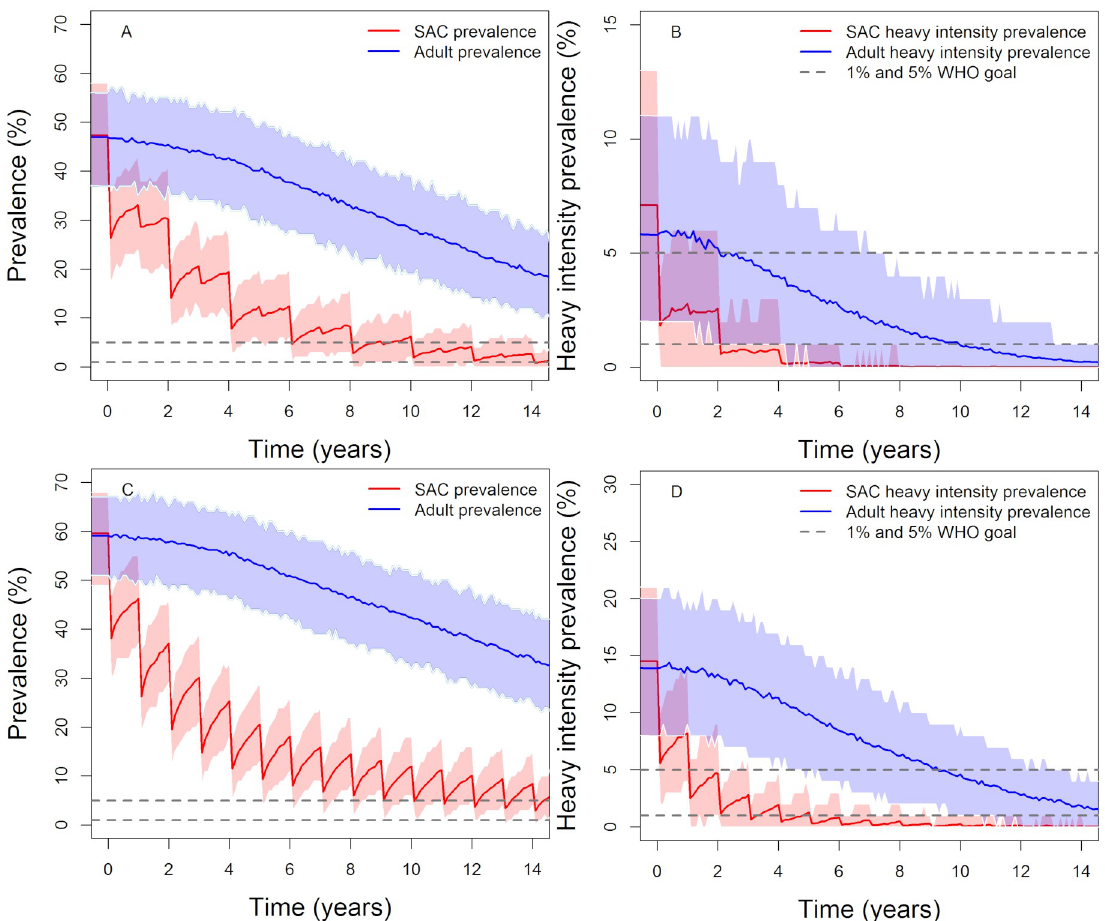
Fig 7. Model projections of vaccination in moderate (first row) and high (second row) baseline transmission settings. The duration of vaccine protection is 5 years, vaccinating 1, 6 and 11-year olds with a coverage of 85%, 60% and 70% respectively, plus MDA given to 75% of SAC (annually in high transmission settings and once every two years in moderate transmission settings). Graphs (A, C), show the prevalence of intensity and Graphs (B, D) show the prevalence of heavy-intensity infections in school-aged children (SAC) and adults. Shaded areas (both blue and red) represent the 90% credible interval (90% of the simulated results fall within these shaded areas).